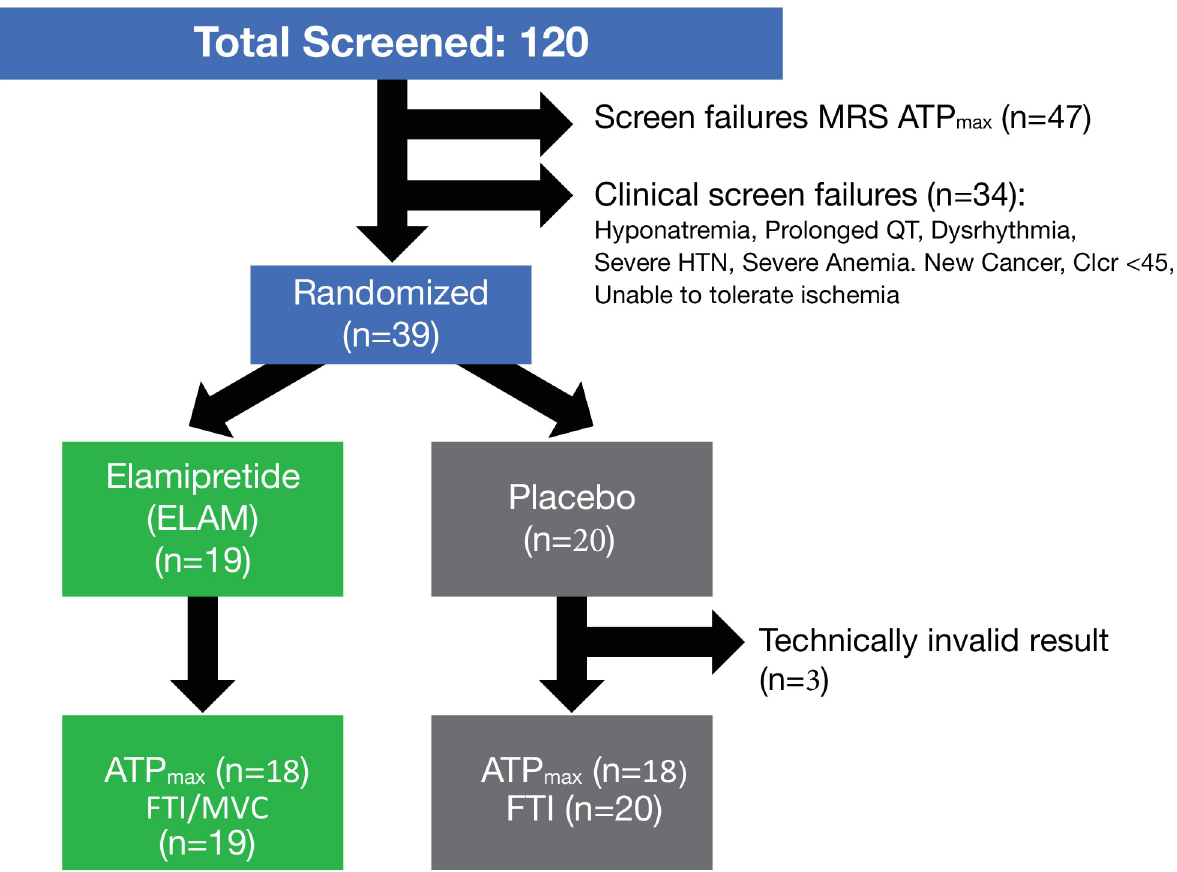
Fig 1. Study schema. The primary endpoint for the study was change in ATP max by phosphorus magnetic resonance spectroscopy ( 31 P MRS) after a 2-hour infusion compared with baseline (screening). The secondary endpoints were a change in mitochondrial coupling (P/O) and muscle force time integral (FTI) compared with baseline (screening).